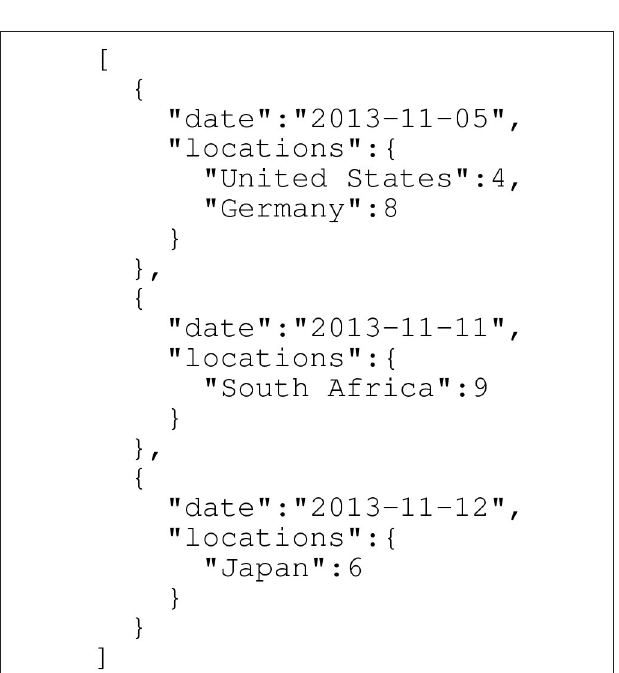
FIGURE 4 | Sample epidemiological case count data in a simple JSON format. Compared to CSV (demonstrated in Figure 3 ), JSON contains more structure that can more rigorously specify data relationships (including hierarchical relationships). Note that this is not EpiJSON; EpiJSON can be quite verbose (due to, for example, metadata specifications and GeoJSON-specified locations), and the authors felt a complete EpiJSON example would take up an unreasonable amount of space in this paper. As in Figure 3 , this time series does not contain real data and only exists for demonstration